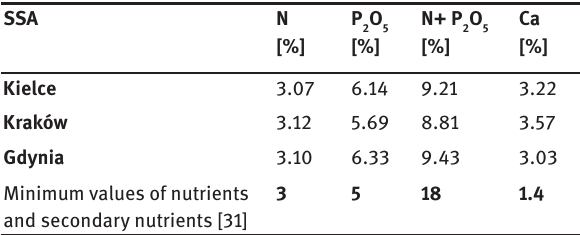
Table 6: Minimum concentration of the nutrients and secondary nutrients in fluid fertilizers according to the Regulation (EC) No 2003/2003 of the European Parliament and to the Council relating to fertilizers with respect to the extract composition.